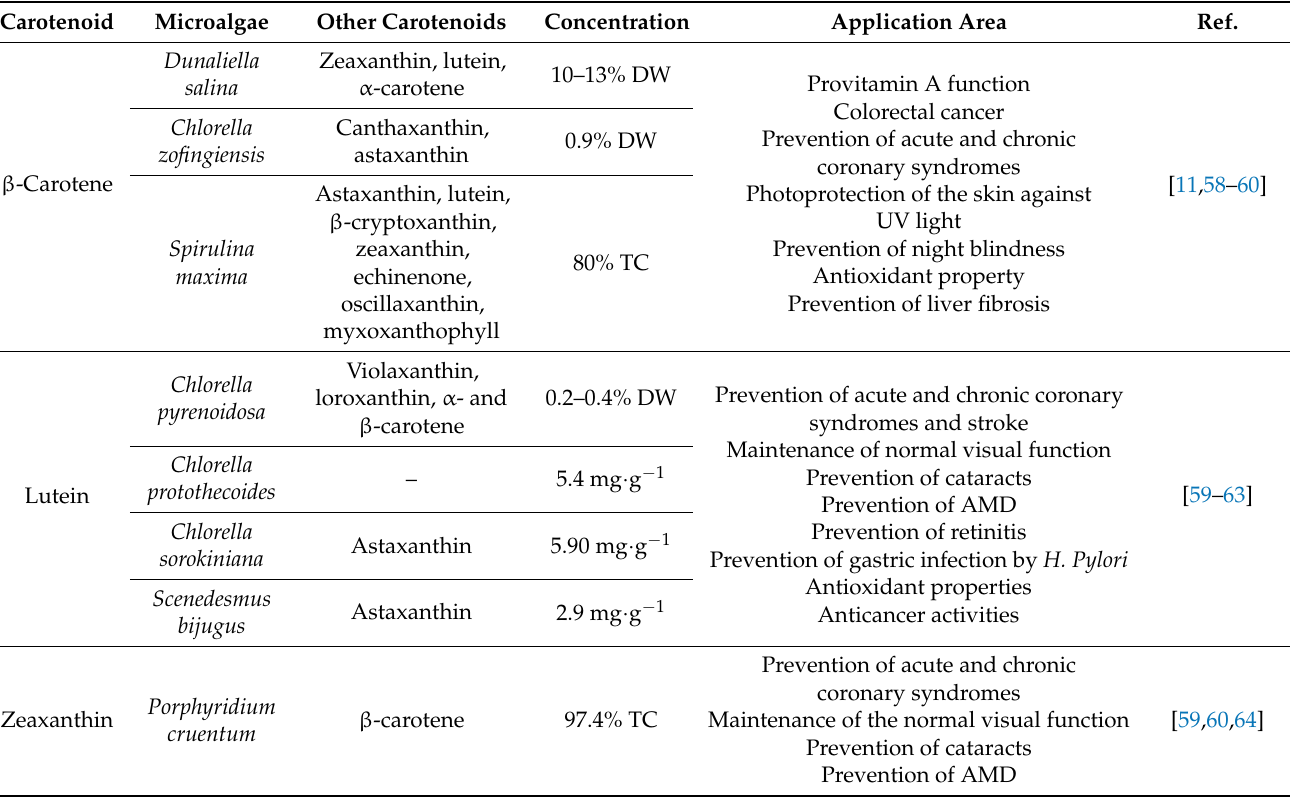
Table 1. Carotenoids produced by